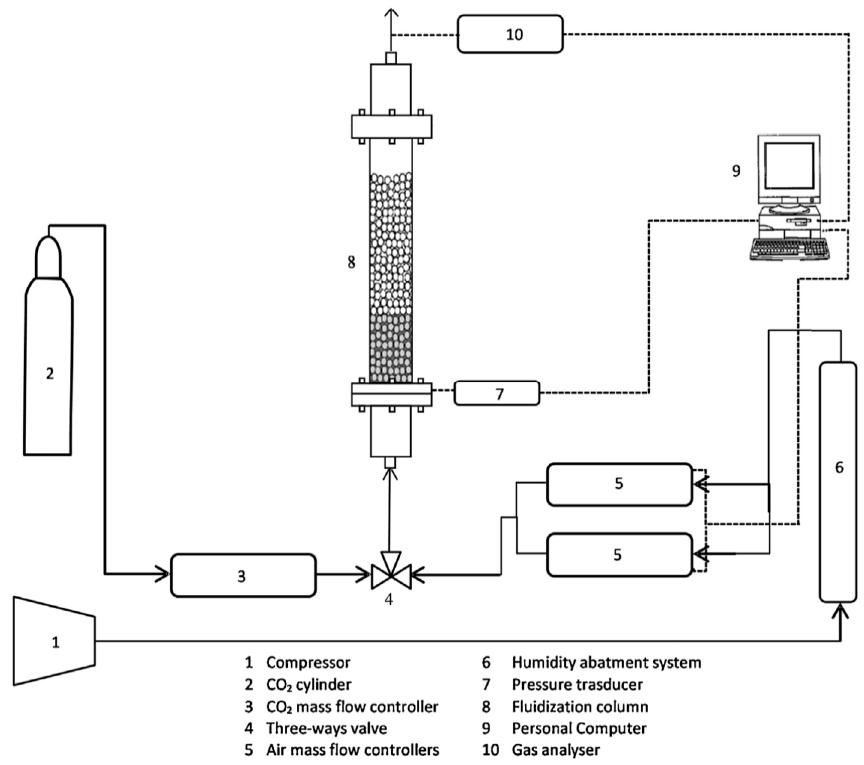
Figure 1. Experimental apparatus.